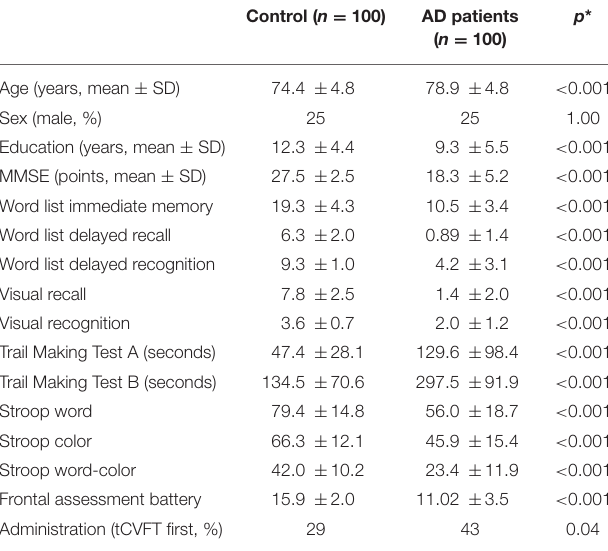
TABLE 1 | Characteristics of the participants.